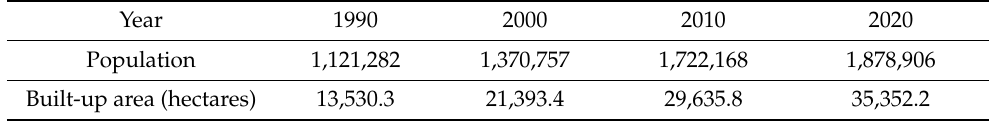
Table 2. Population and built-up area change from 1990 to 2020